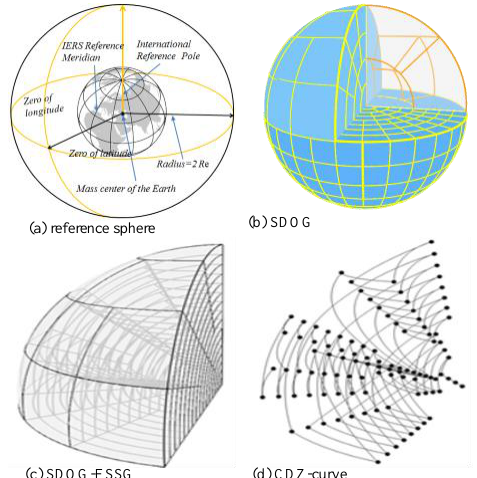
Fig.1 SDOG-based Earth System Spatial Grid (SDOG-ESSG) and its CDZ-curve.